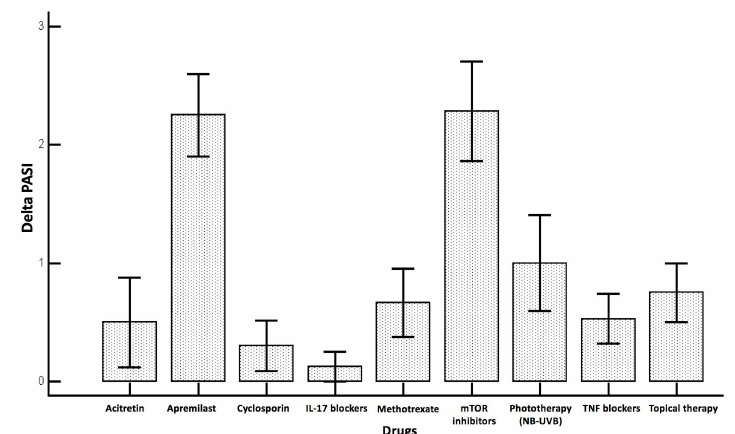
Figure 2. Change in the “Psoriasis Area and Severity Index” (PASI) score before and after the Ramadan fasting, broken down according to the received drug. Abbreviations: IL-17 (interleukin-17); mTOR (mammalian target of rapamycin) inhibitors; NB-UVB (narrow band ultraviolet B); PASI (“Psoriasis Area and Severity Index”); TNF (tumor necrosis